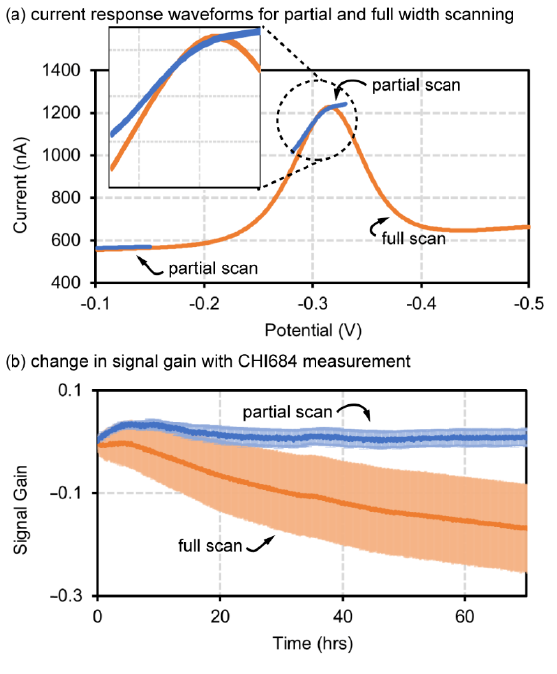
Figure 3. Signal gain results of partial scanning techniques. ( a ) Comparison of square wave voltam- mograms between conventional full scan SWV window and partial width scan SWV, with an insert comparing redox peak shape. ( b ) Signal gain degradation of full and partial scanning SWV.